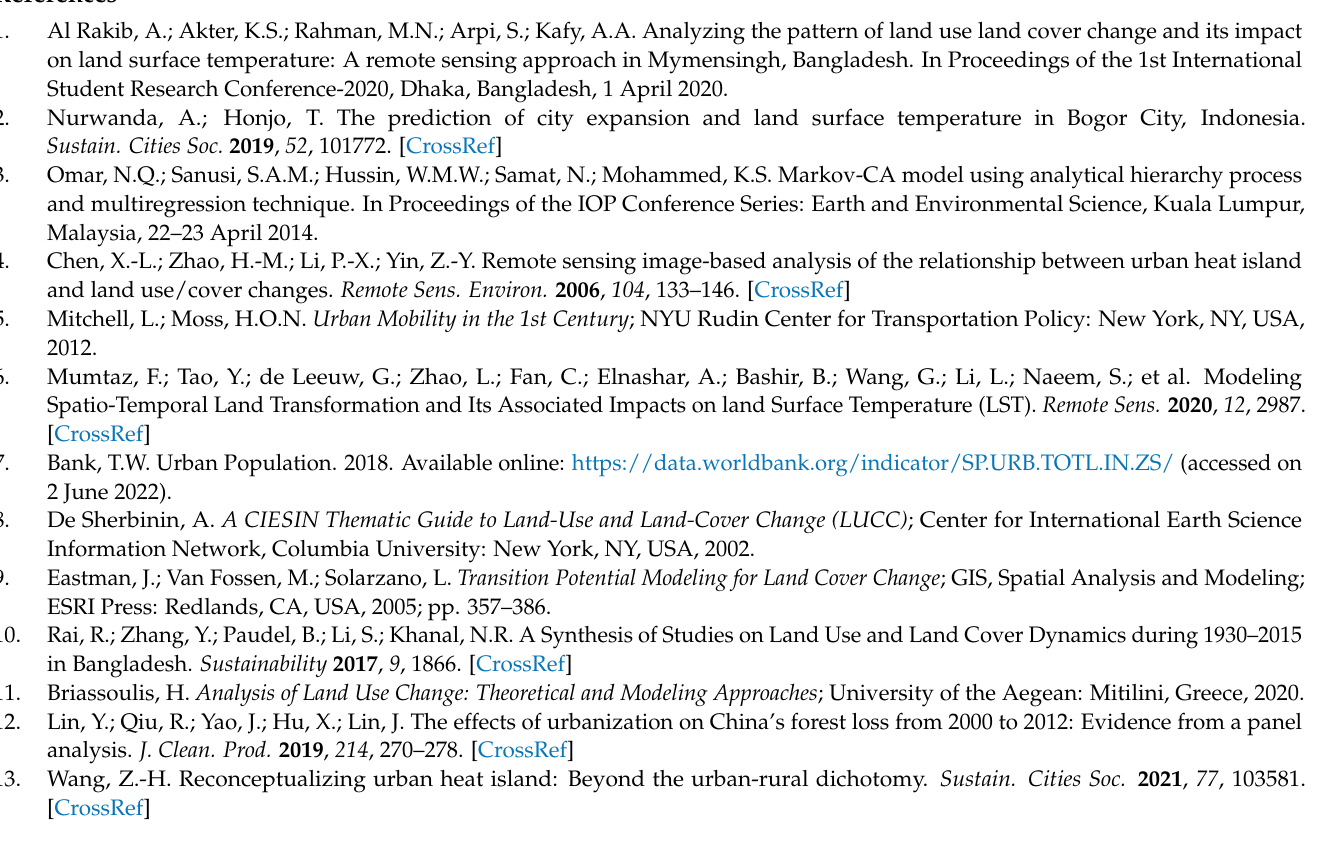
Table S5: LULC gain and loss over KPK and Punjab 2000–2020; Figure S1: (a). Lahore metropolitan area Master Plan 2021; (b). Lahore metropolitan area Master Plan